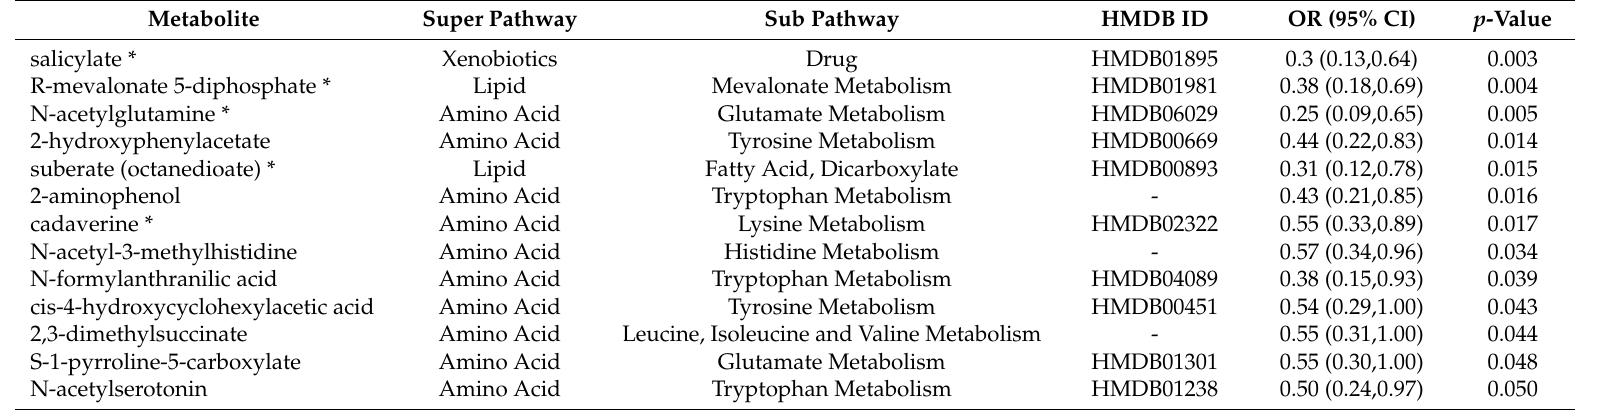
Table 3. Stool metabolites associated with binary ASQ communication score